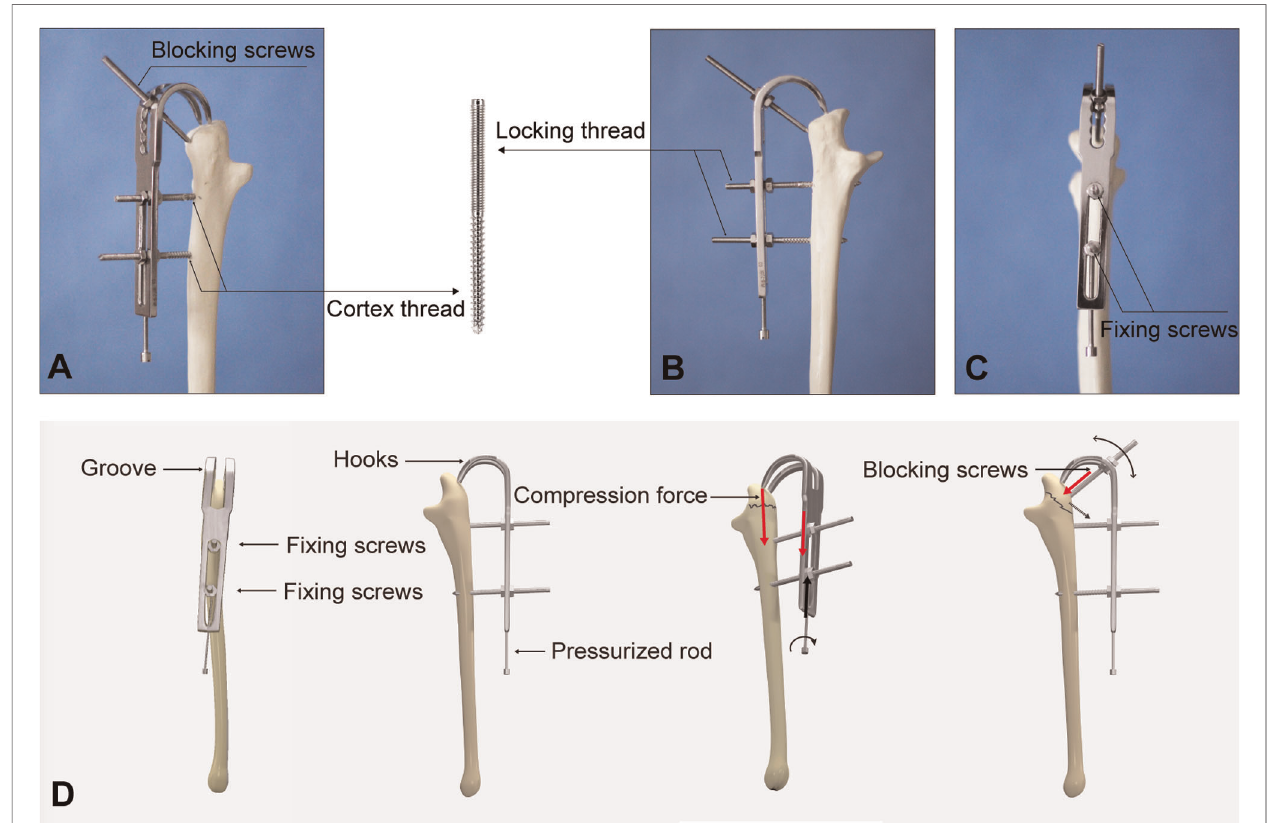
FIGURE 1 | Structure of the J-shaped external fi xator (J-EF). General view of the J-EF ( A – C ). Structure and the compression system of J-EF ( D